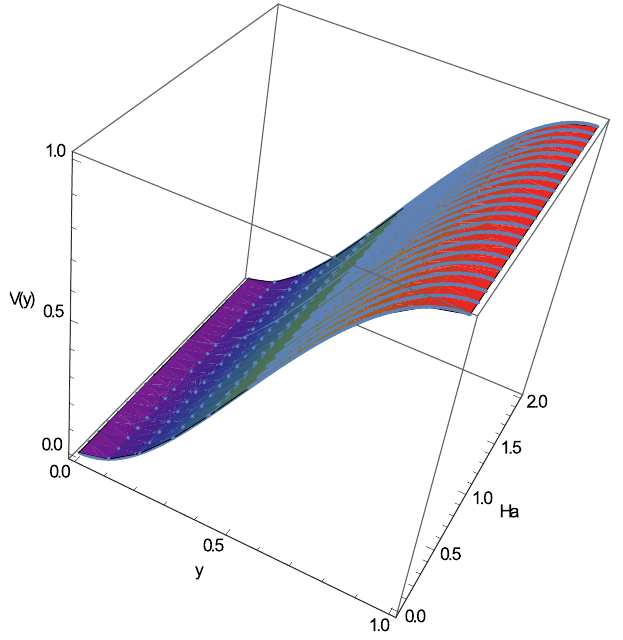
Figure 6. The effect of the increase of Ha on V for the case Re = 1—three dimensional plot.